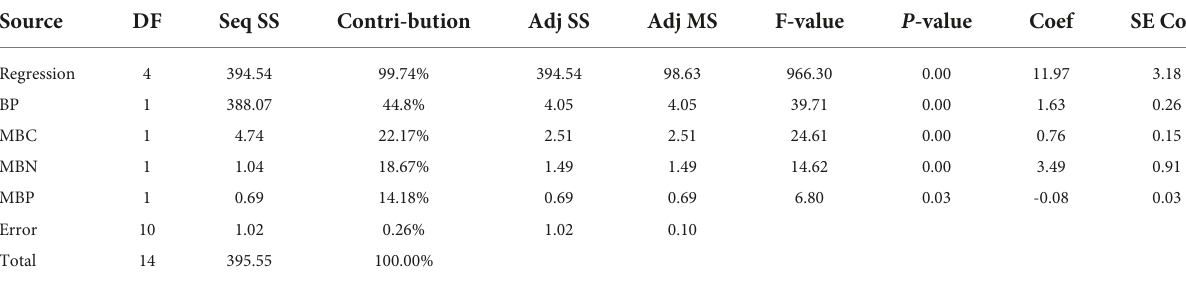
TABLE 8 Stepwise regression variances analysis of different soil biological properties in cauliflower-cowpea-okra cropping